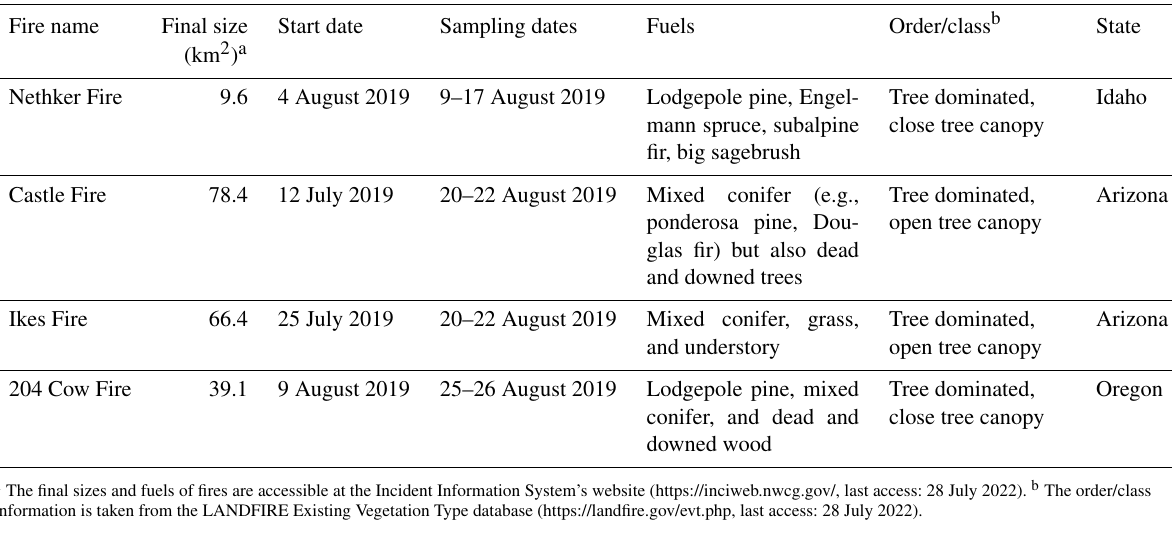
Table 1. Key characteristics of wildfires studied.